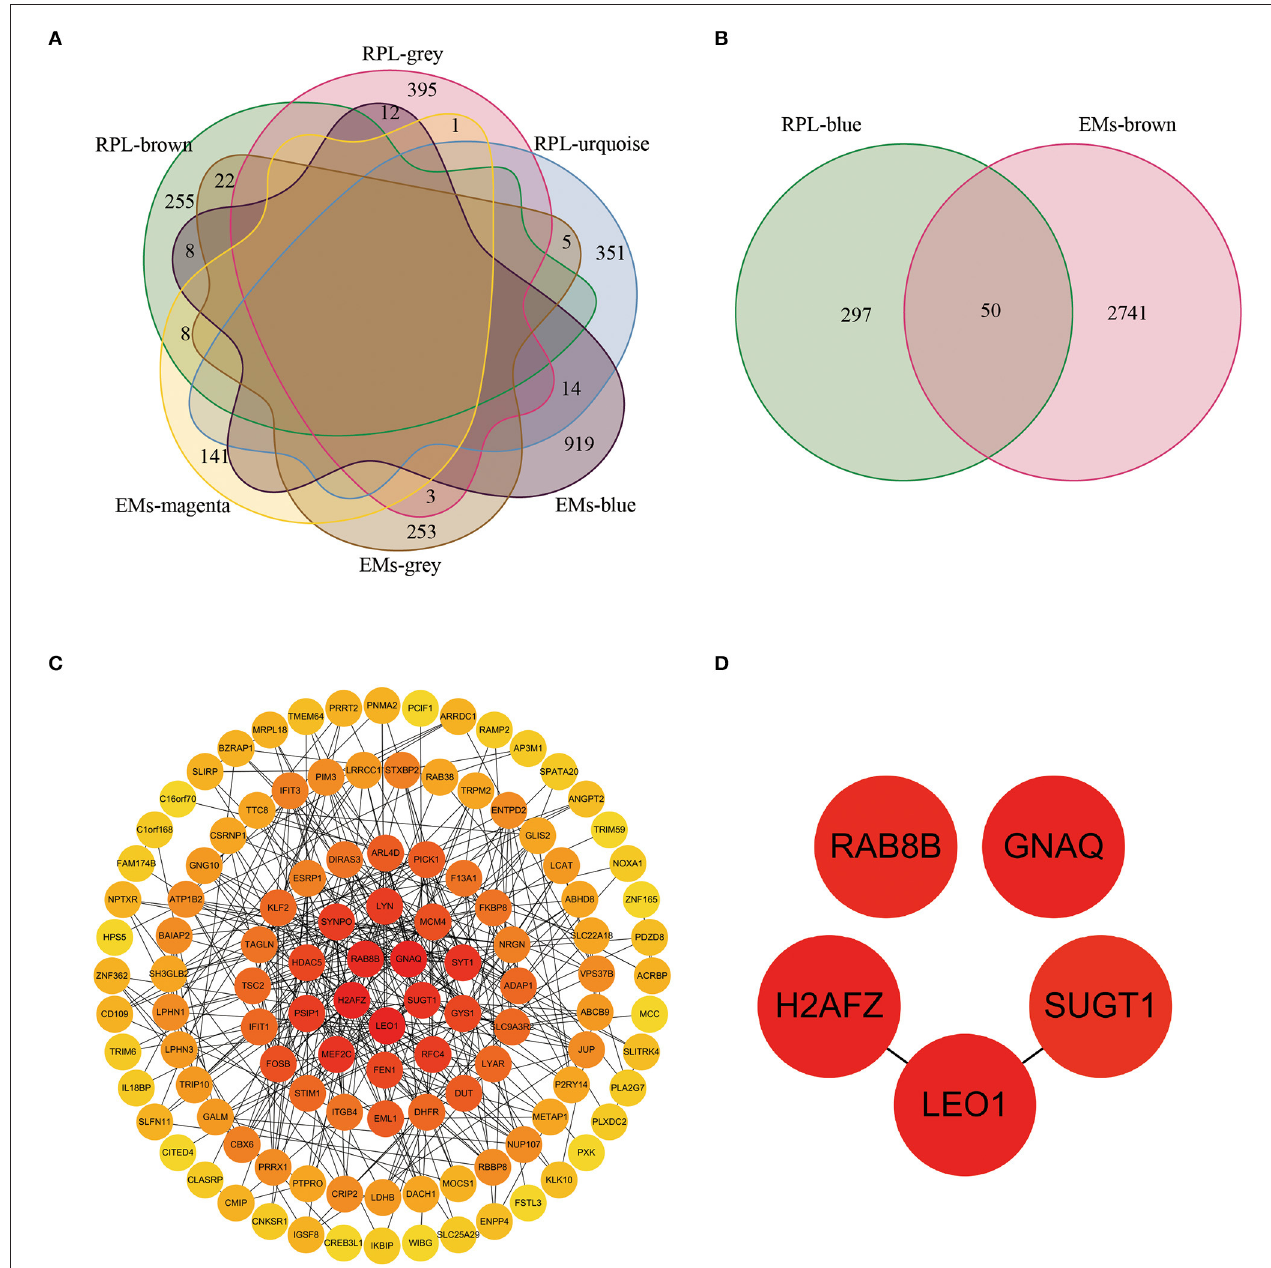
FIGURE 4 | The shared genes and PPI network between the EMs-related gene modules and the RPL-related gene modules. (A) Shared genes between gene modules negatively correlated with EMs and gene modules negatively correlated with RPL (module correlation greater than 0.4). (B) Shared genes between gene modules positively correlated with EMs and gene modules positively correlated with RPL (module correlation greater than 0.4). (C) PPI network constructed by EMs and RPL shared genes. (D) Core shared genes for EMs and